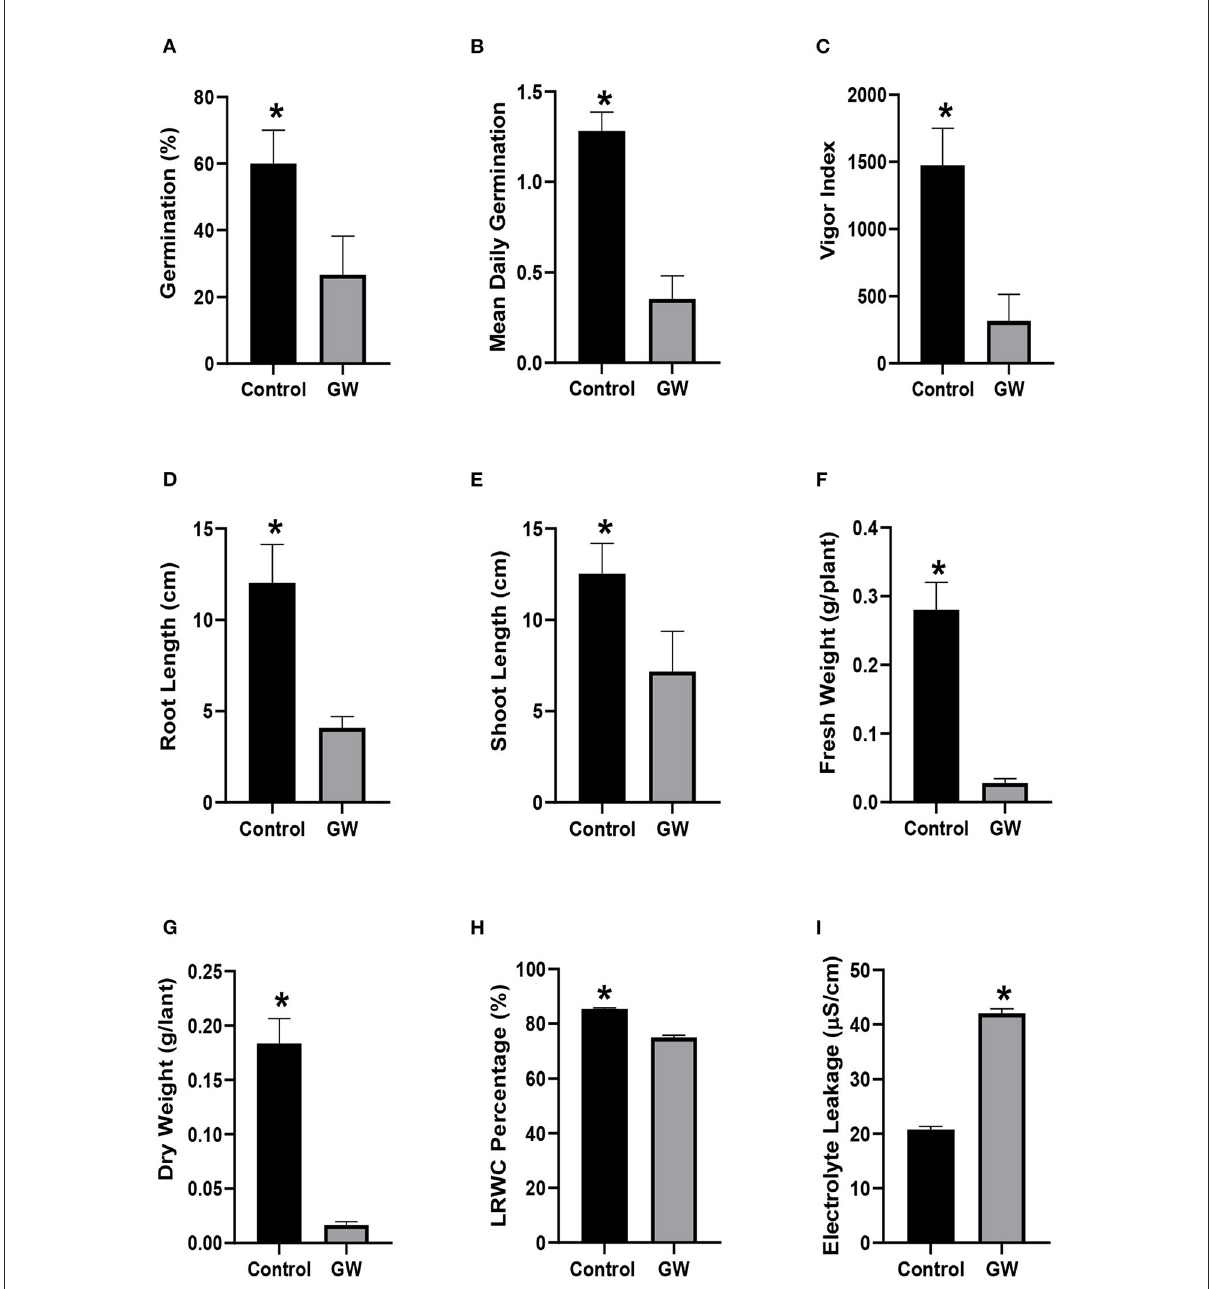
FIGURE5 Weedicide potential of GW against Avena fatua (A) germination percentage, (B) mean daily germination, (C) vigor index, (D) root length, (E) shoot length, (F) fresh weight, (G) dry weight, (H) LRWC, and (I) EC. Bars show the mean of three replicates with standard deviation. Bars labeled with * are significantly higher ( t -test; p <